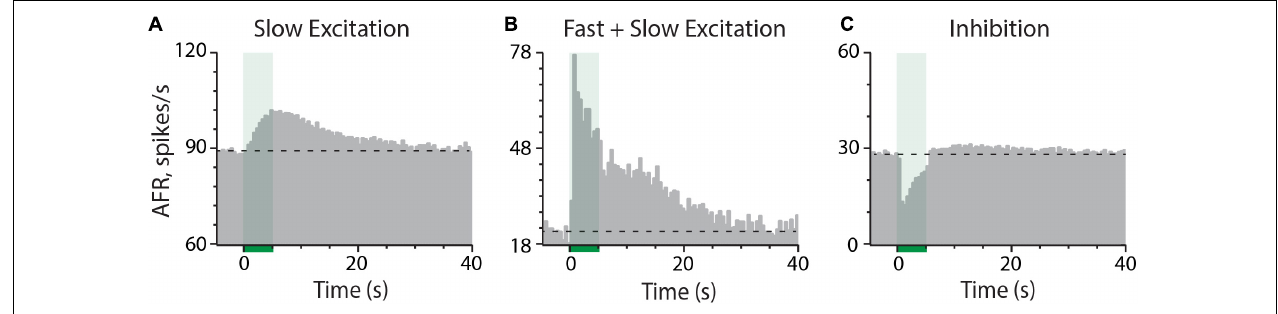
FIGURE 1 | Electrical stimulation of vestibular efferent neurons can elicit three distinct effects on afferent discharge including (A) slow excitation, (B) combined fast and slow excitation, and (C) inhibition. In (A–C) , an average response histogram to 7, 6, and 8 efferent shock trains (each 333 shocks/s for 5 s, green column at t = 0–5 s) were constructed for the three different afferents, respectively, from three different animals. Dashed horizontal lines represent the prestimulus baseline afferent firing rate. Binning in all panels is 500 ms.